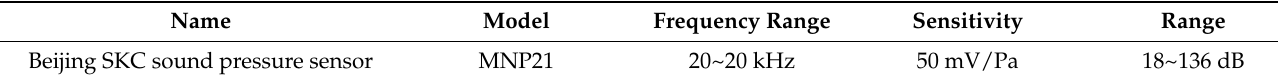
Table 2. Sensor parameters.